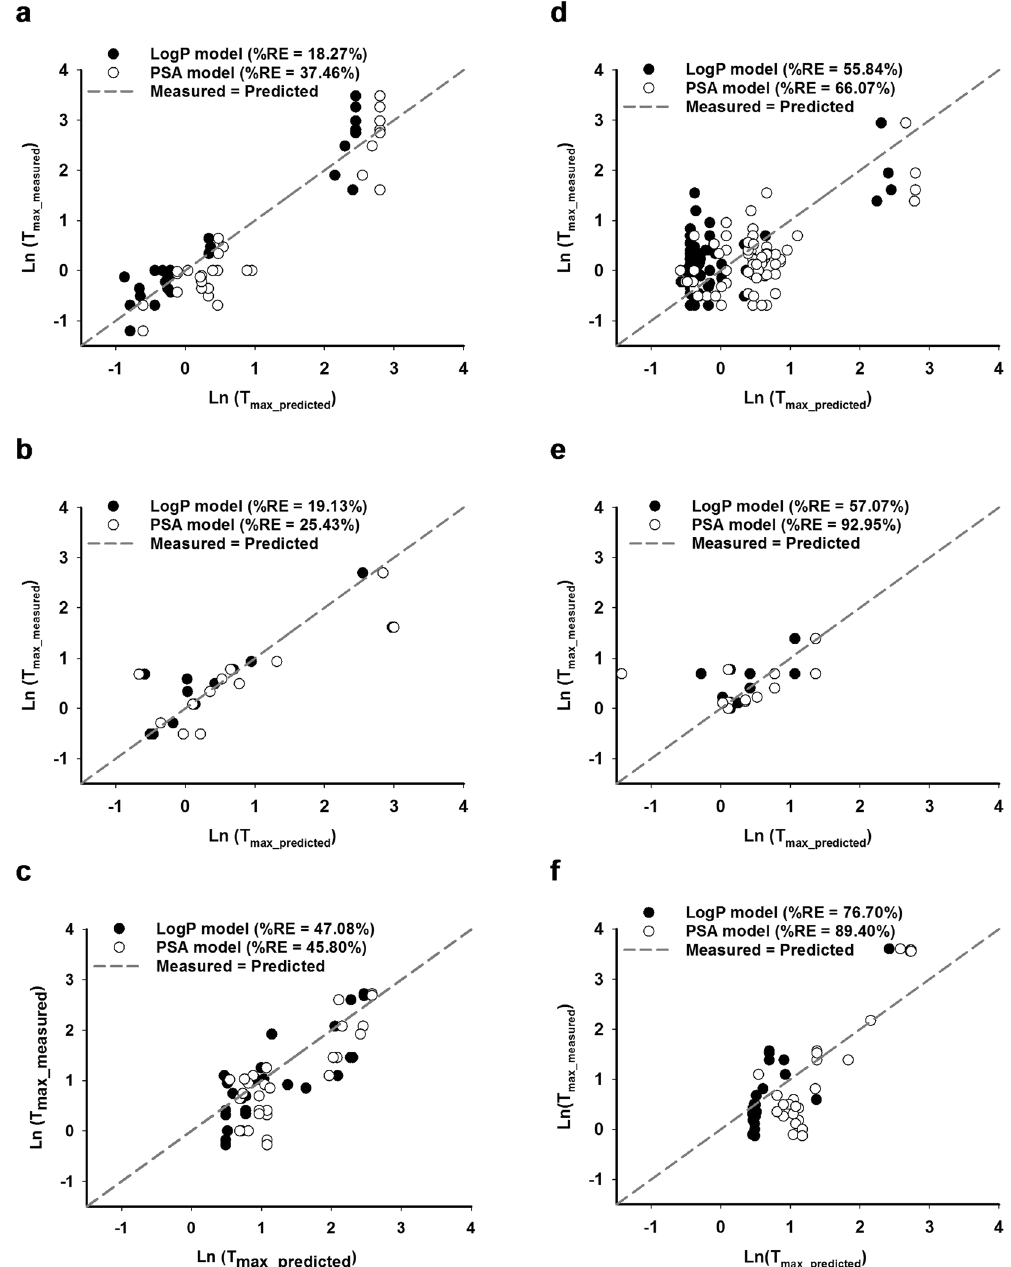
Figure 3. Comparison of measured versus predicted values of T max of the training dataset and the PCv dataset. Natural logarithm of T max measured from the training dataset (N = 67) were plotted against natural logarithm of predicted T max based on the log P model (black circle), the PSA model (clear circle) and compared to the regression of measured T max = predicted T max (dotted line) when intake as ( a ) liquid, ( b ) semi-solid and ( c ) solid forms. Similar comparison was plotted for the PCv dataset (N = 108) when intake as ( d ) liquid, ( e ) semi-solid and ( f ) solid